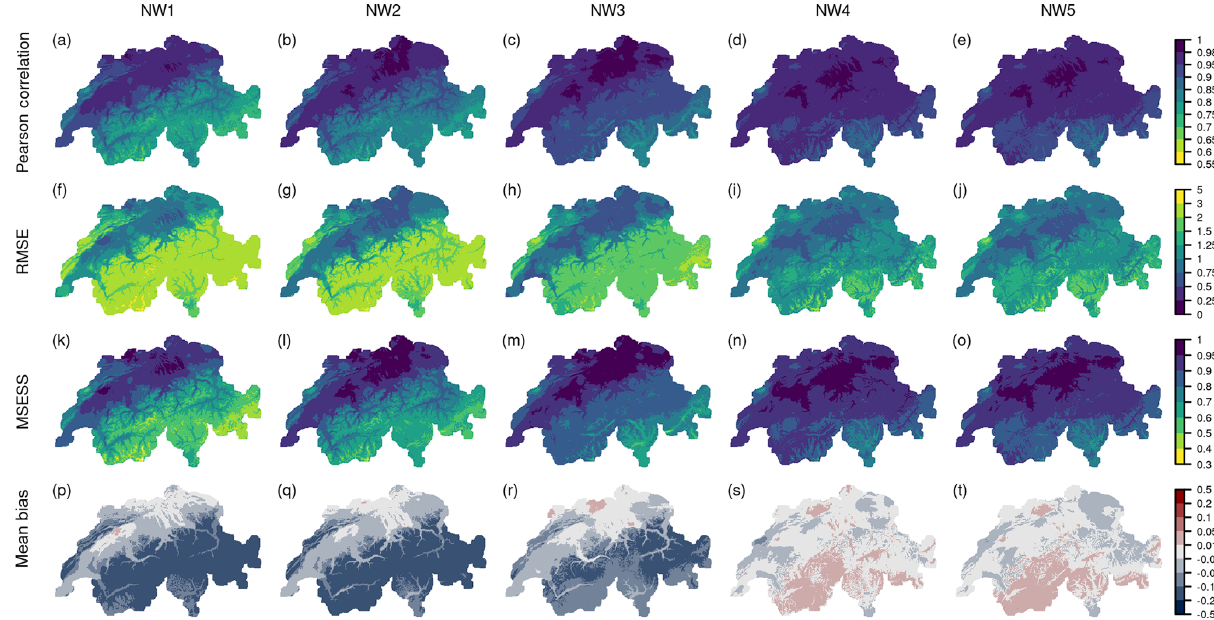
Figure A1. Cross-validation results of all networks shown in Fig. 1a–e with 11, 21, 32, 43, and 108 time series used for reconstructing the precipitation fields. The cross-validation results are based on annual de-seasonalized temperature anomalies during 1961–2020. (a–e) Pearson correlation, (f–j) RMSE, (k–o) MSESS, and (p–t) mean bias.